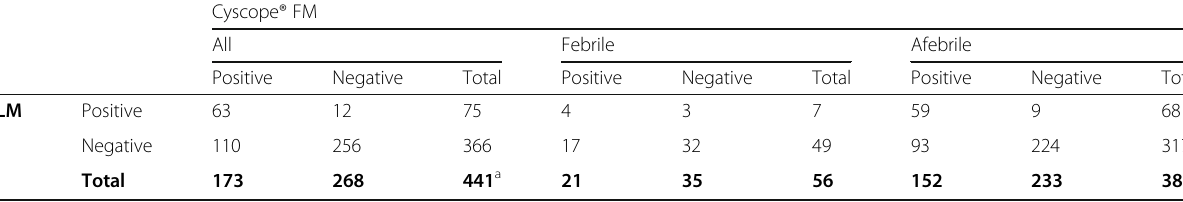
Table 3 Cyscope® FM results compared to LM results with respect to clinical status